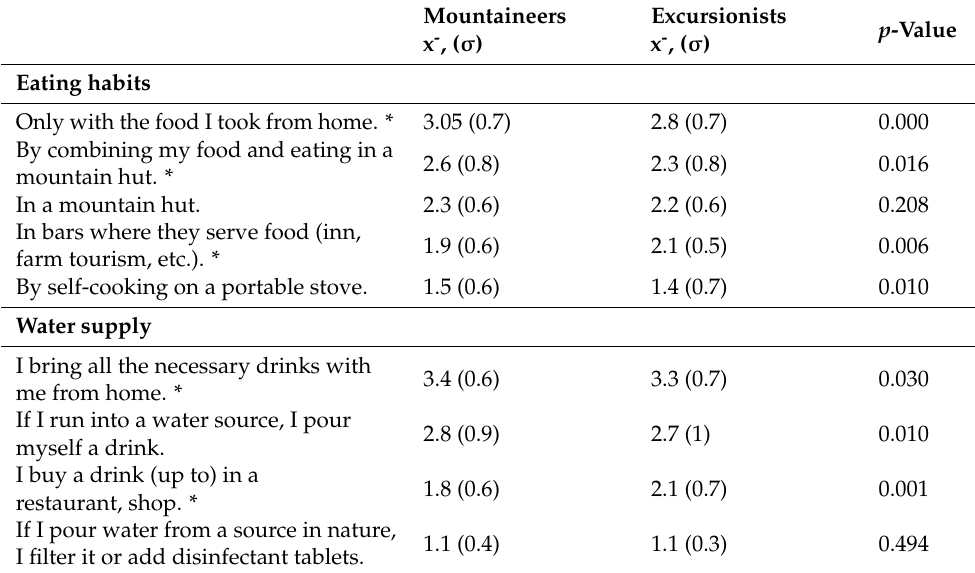
Table 1. Eating habits and water supply on nature trips.